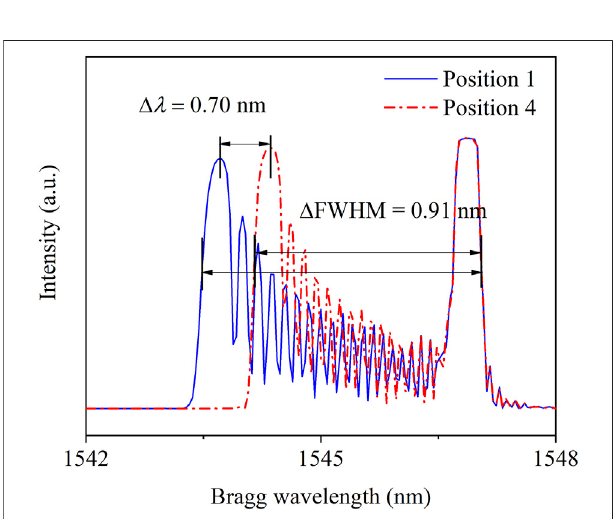
FIGURE 13 | Reconstruction spectrum by the TMM in position 1 and position 4 of the experimental